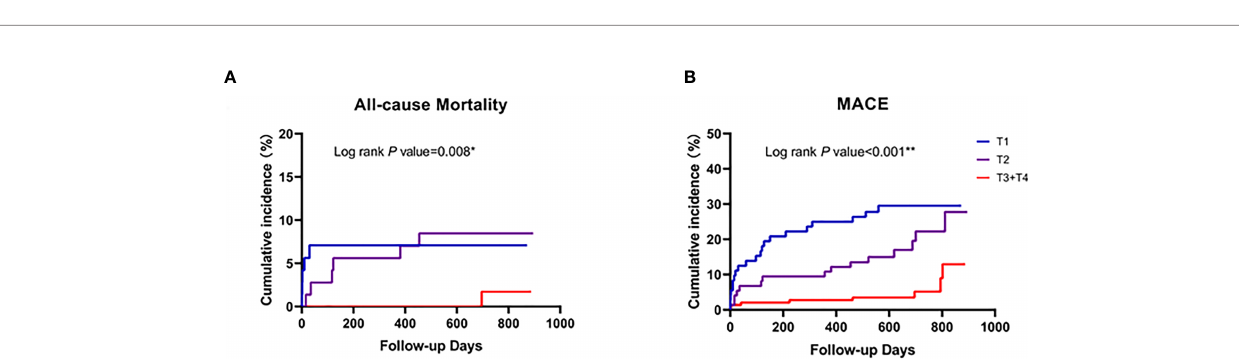
FIGURE 4 | Comparison of the cardiovascular events post-PCI between patients with low and high Lactobacillus levels. Follow-up cardiovascular events included all-cause death (A) and the MACE-cumulative incidence (B) . Patients were strati fi ed according to the high value of Lactobacillus level (T3+T4, 7.32 log 10 copies/g) in ACS patients. *p < 0.05; **p <